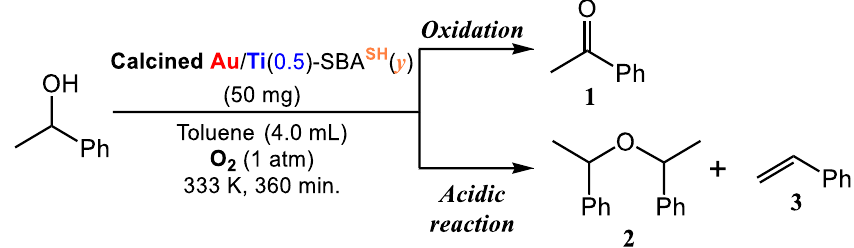
Table 3. Conversion of 1-phenylethanol mediated by the calcined catalysts under O 2 .